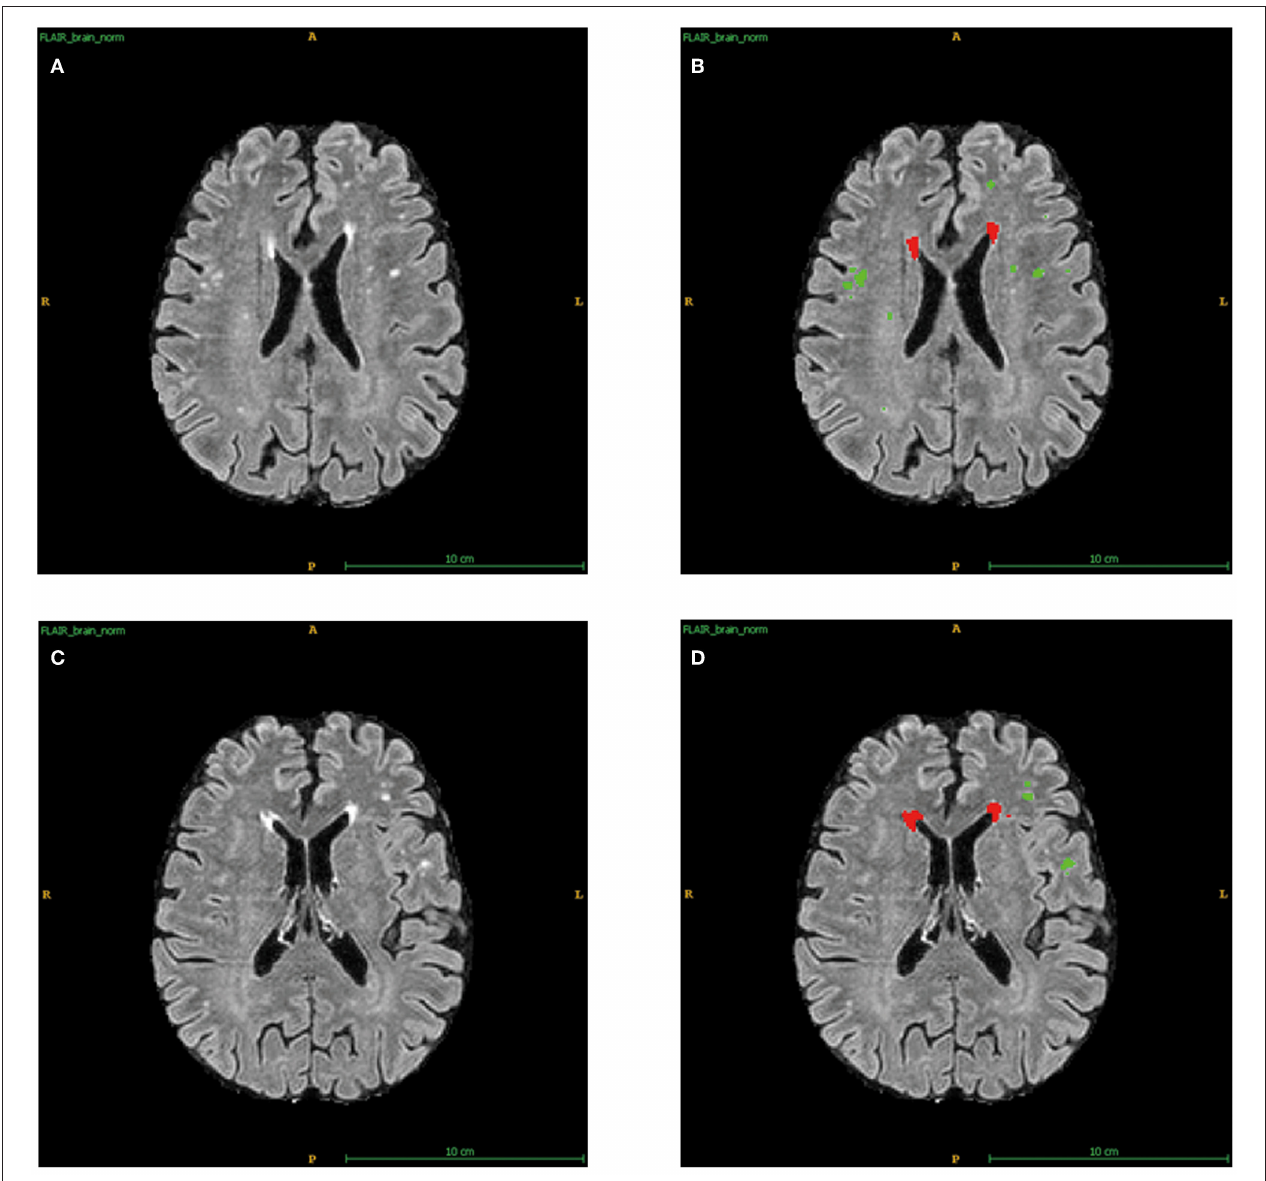
FIGURE 1 | Automatic segments of PVWMHs and DWMHs applied by AccuBrain®. (A) The original T2-FLAIR images of sample 1. (B) Automatic division of PVWMHs (Red) and DWMHs (Green) for (A) . (C) The original T2-FLAIR images of sample 2. (D) Automatic division of PVWMHs (Red) and DWMHs (Green) for (C) .